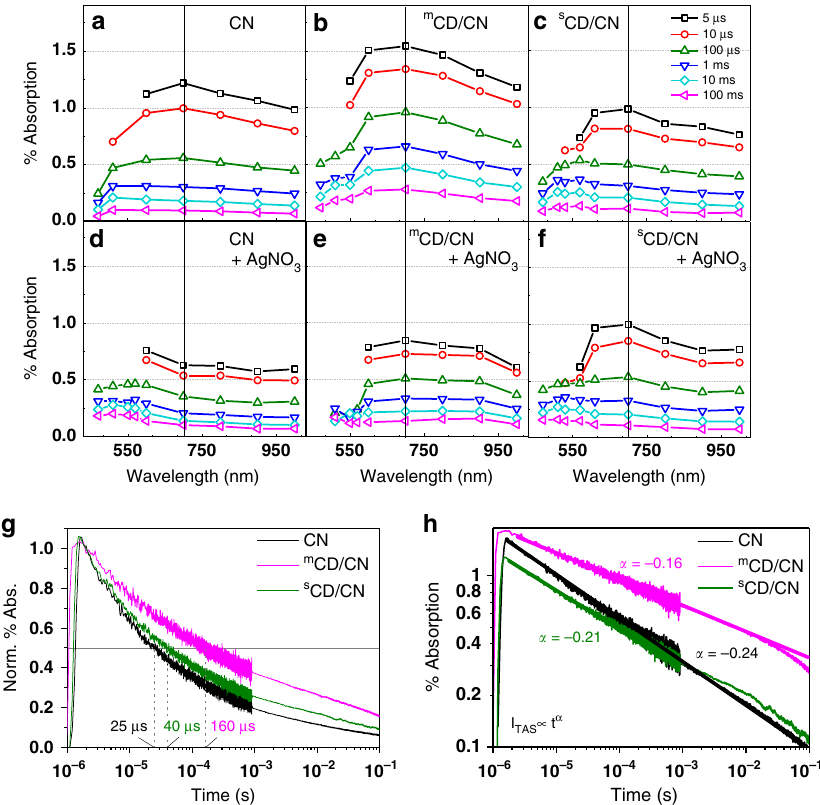
Fig. 2 TAS measurements of CN, m CD/CN and s CD/CN. Diffuse re fl ectance TAS spectra for samples with ( a – c ) and without ( d – f ) 10 mM AgNO 3 . CN ( a , d ), m CD/CN ( b , e ) and s CD/CN ( c , f ) were dispersed in aqueous solution. The change of signal amplitude at 700 nm indicates it should be mainly assigned to the electron signal in CN and m CD improves the charge separation on CN due to hole transfer from CN to m CD. g μ s-TAS decay kinetics of CN, m CD/CN and s CD/CN in water monitored at 700 nm and excited by pulsed 355 nm excitation (460 μ J/cm 2 ) and h fi tted α parameters indicated in the same color as the associated trace. Source data are provided as a Source Data fi